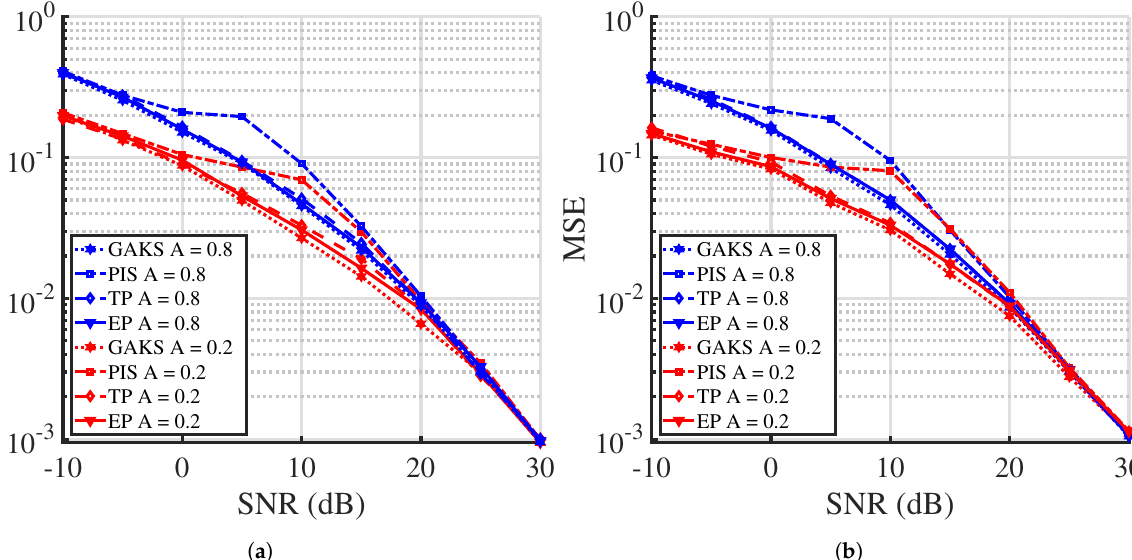
Figure 5. Signal estimation, based on the hard (PIS) or soft (EP and TP) decisions. M = 4 noise states with A = 0.2 or 0.8: ( a ) Γ = 0.01, ( b ) Γ =